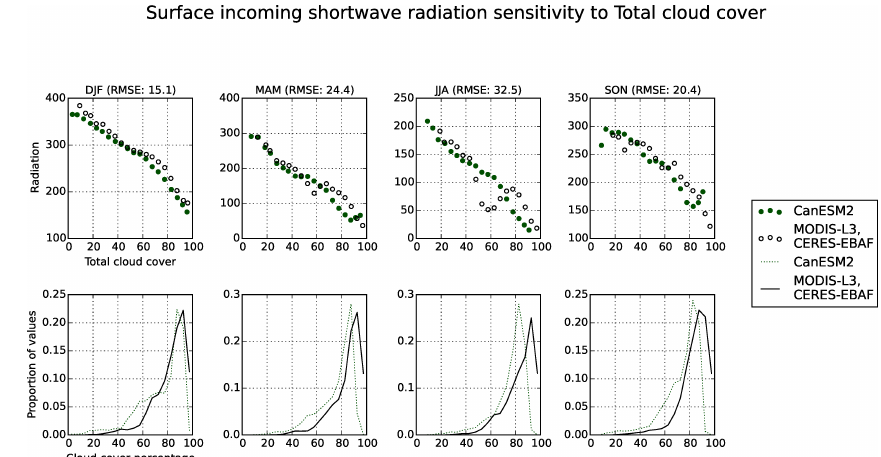
Figure 15. Upper panel: covariability between incoming surface shortwave radiation (rsds) and total cloud cover (clt). Lower panel: fraction occurrence histograms of binned cloud cover: observations are CERES-EBAF (radiation) and CloudSat (cloud cover). The CanESM2 model from the CMIP5 archive is shown as an example for comparison to observations (the namelist runs on all CMIP5 models). CanESM2 generally reproduces the observed slope of rsds as a function of clt, although there is a systematic positive bias in the amount of shortwave radiation reaching the surface for most cloud cover values. A positive bias is also seen in the CanESM2 histogram of cloud occurrence, with a strong peak in seasonal cloud fraction of 90% in most seasons. Produced with namelist_SouthernHemisphere.xml